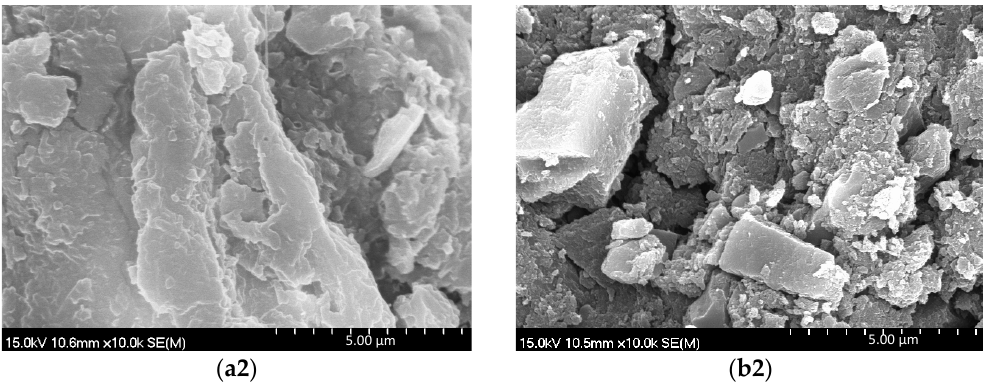
Figure 4. Gardenia powder at 300× magnification ( a1 ) and 10,000× magnification ( a2 ). Milled mixture of active carbon and gardenia (powder-to-ball weight ratio at 1:5, rotation rate at 200 rpm and milling 5 min) at 300× magnification ( b1 ) and 10,000× magnification ( b2 ).